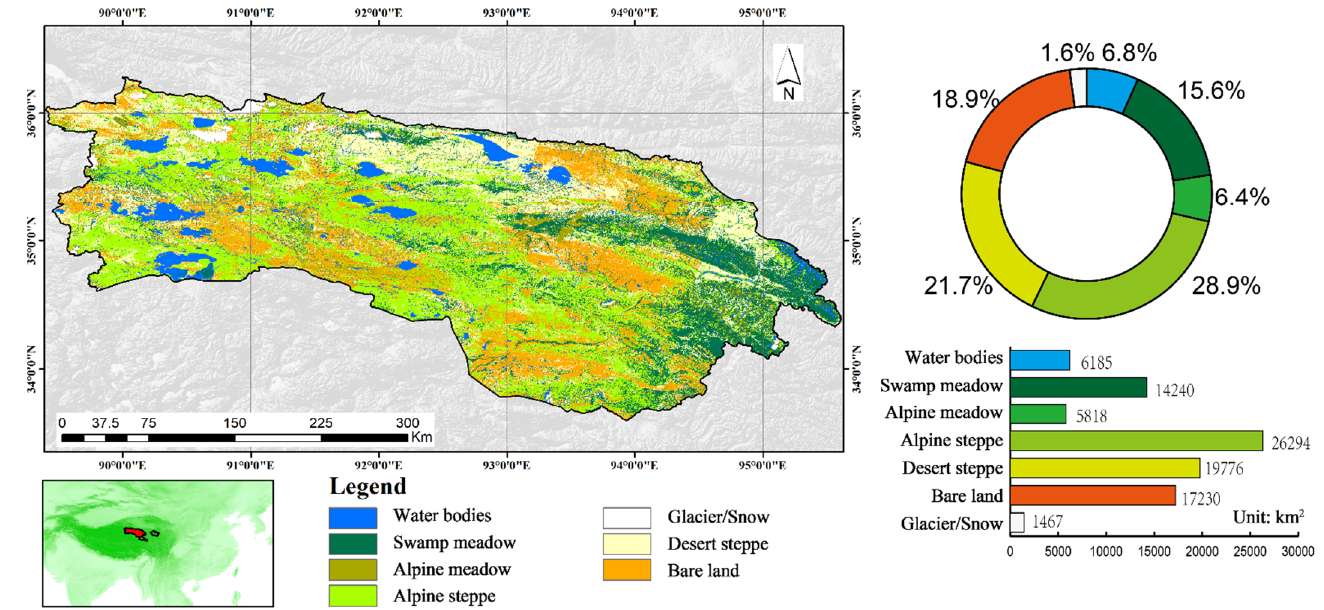
Figure 9. Vegetation classification results of 2021 in the headwater of the Yangzi River in Sanjiangyuan National Park.